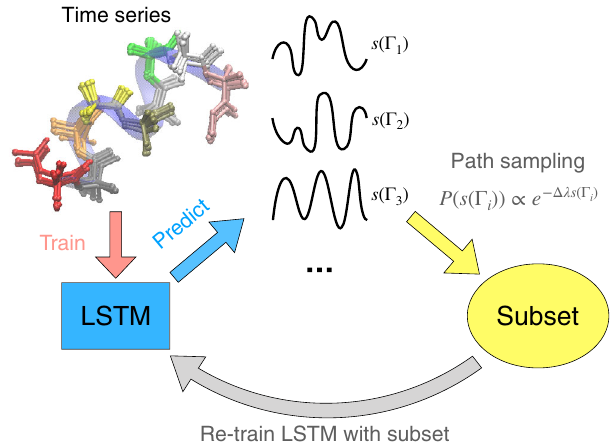
Fig. 1 | Procedure for path sampling LSTM. This schematic plot shows the work fl ow for constraining some static or dynamical variable s ( Γ i ), given an unconstrained LSTM model. The work fl ow begins with generating numerous pre- dicted trajectories from the constraint-free LSTM model. The corresponding vari- ables that we seek to constrain can be calculated from the predicted trajectories andaredenotedby s ( Γ 1 ), s ( Γ 2 ), s ( Γ 3 )intheplot.Wethenperformpathsamplingand select a smaller subset of trajectories in a biased manner that conforms to the desired constraints, with a probability P ð s ð Γ i ÞÞ / e (cid:2) Δ λ s ð Γ i Þ , where Δ λ issolvedbythe Eq. (6). The subset is then used as a new dataset to train the LSTM